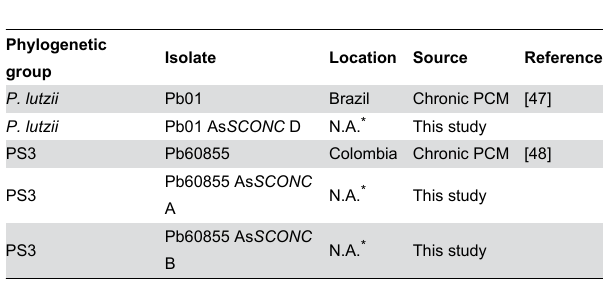
Table 1. Paracoccidioides species used in this